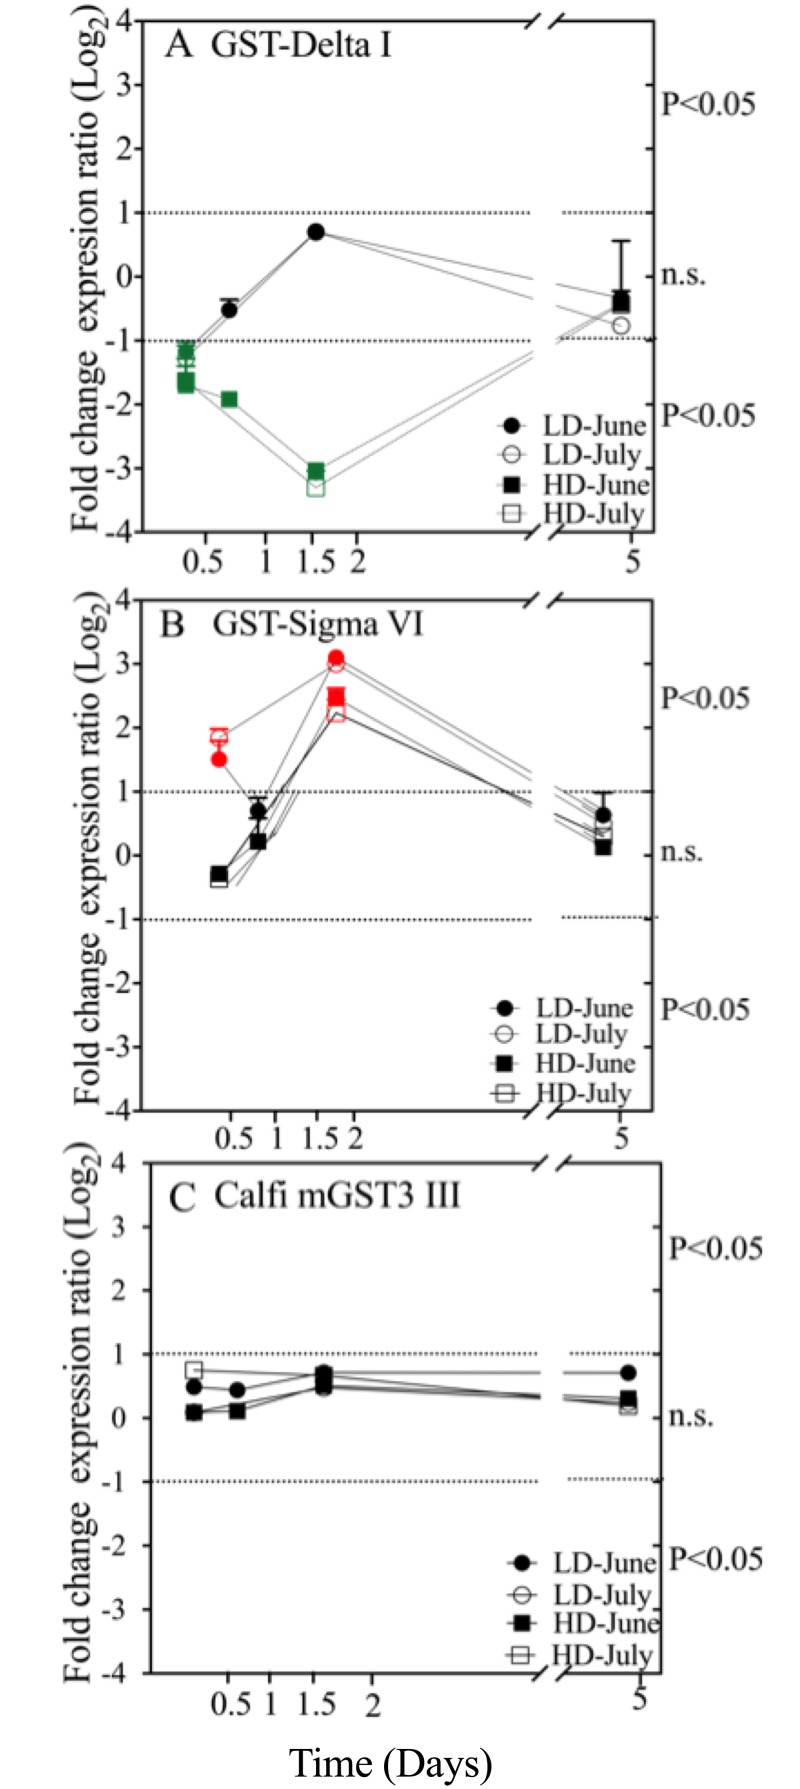
Glutathione S-transferase relative expression over time in C. finmarchicus feeding on A. fundyense diets for a total of 5 days.Relative expression of three GSTs members of the cytosolic Delta I (A) and Sigma VI (B) subclasses and the microsomal mGST-3 III (C) was measured at each time point for C. finmarchicus adult females feeding on LD and HD of A. fundyense in June and July experiments using RT-qPCR. GST expression (Log2 fold change) was normalized using EFA. The dotted lines delimit expression levels that are not significantly different from the control (Log2 Fold change < = 1). Solid symbols: June experiment; open symbols: July experiment; circles: LD treatment; squares: HD treatment. Significant differential expression of Calfi Delta I (A) between the control and the experimental treatment is shown in green, and for GST-Sigma VI (B) in red. Day 1 data for July experiment are not available.